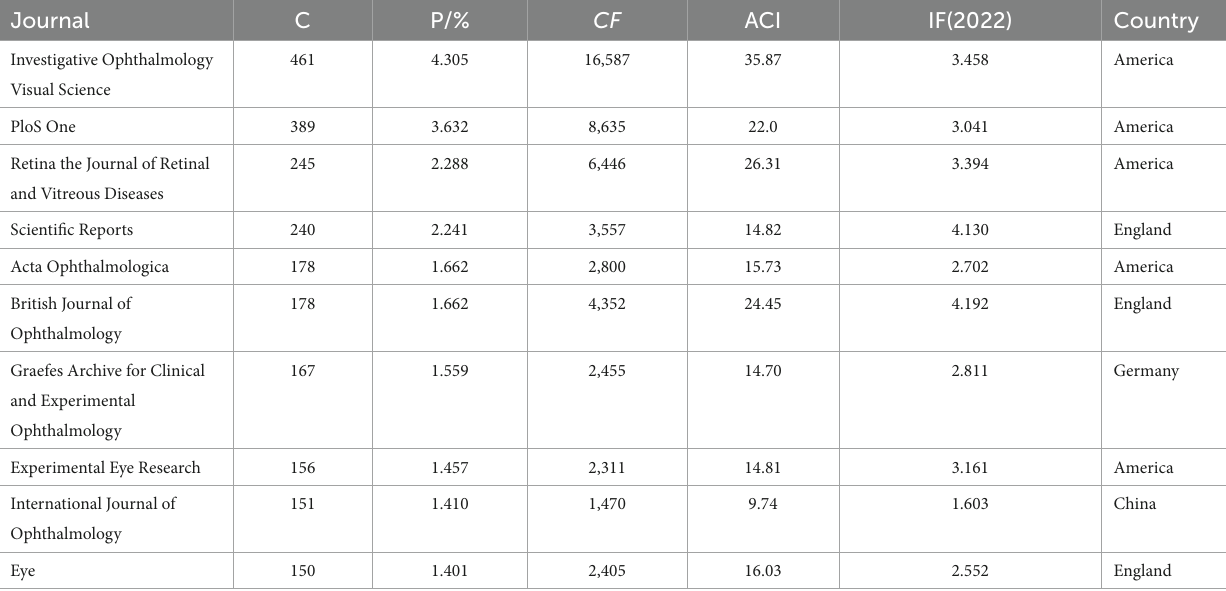
TABLE 3 Top 10 periodicals by the volume of